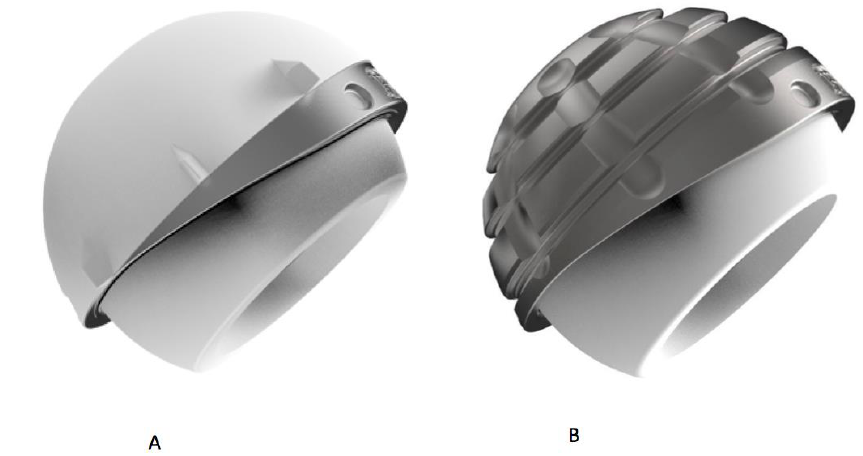
Figure 4. «Quattro» acetabular component with its “hat configuration” or “cupules à casquette”: part ( A ) shows the cementless component and part ( B ) the cemented one. Courtesy of Groupe Lépine, Genay, France.